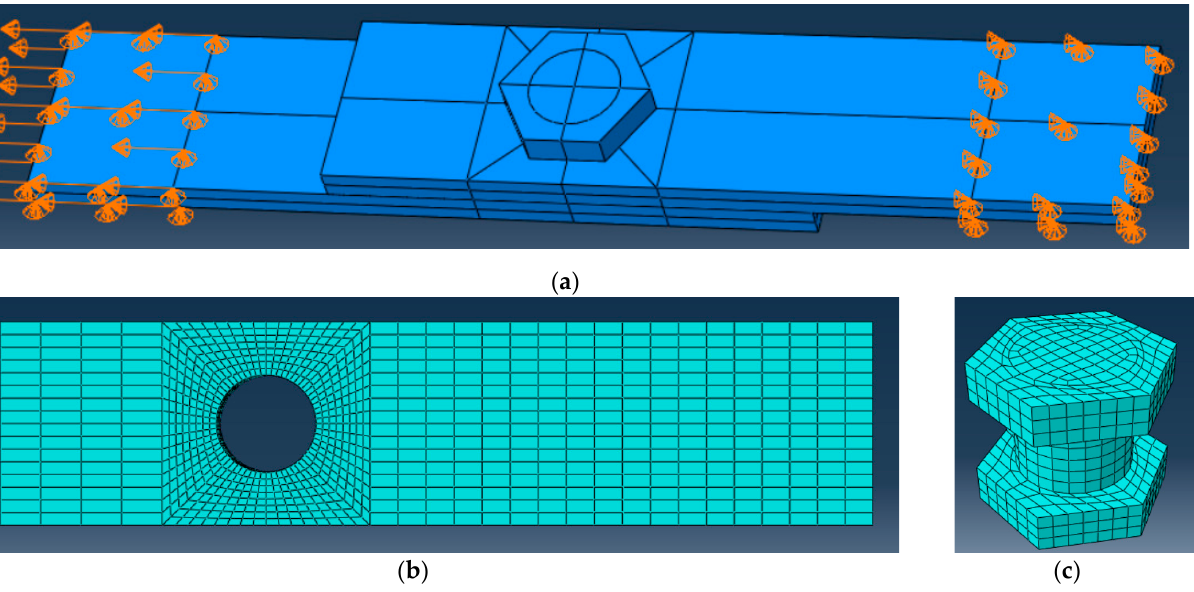
Figure 9. The FE model of the tested joints: ( a ) loading scheme and boundary conditions; ( b ) FE mesh of GFRP plate; ( c ) FE mesh of the steel bolt. Table 8. FE model assumptions.